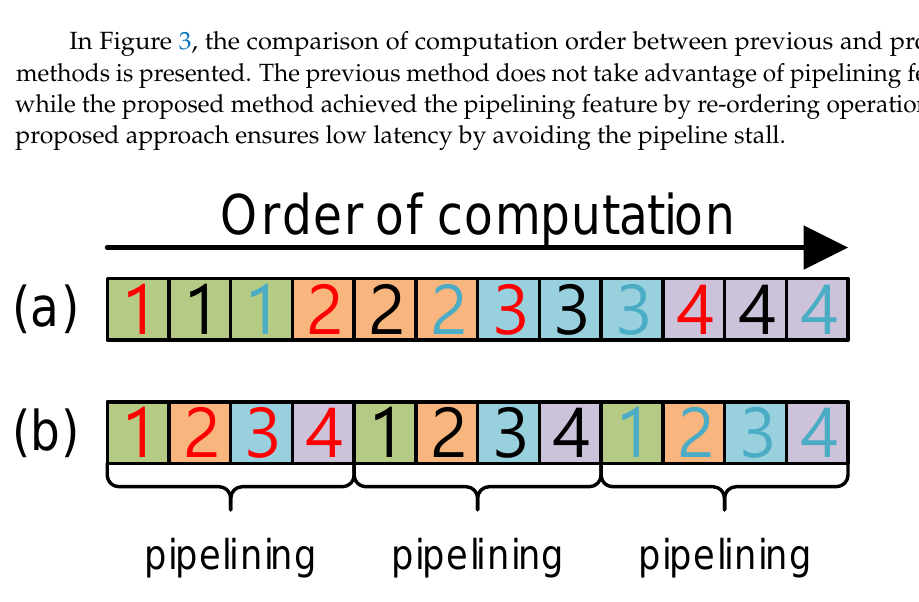
Figure 3. Order of computation between previous and proposed look-up table access. ( a ) Previous approach. ( b ) Proposed approach. Red, black, and blue characters represent offset setting for address pointer, memory access, and result accumulation, respectively. The block indicates the specific